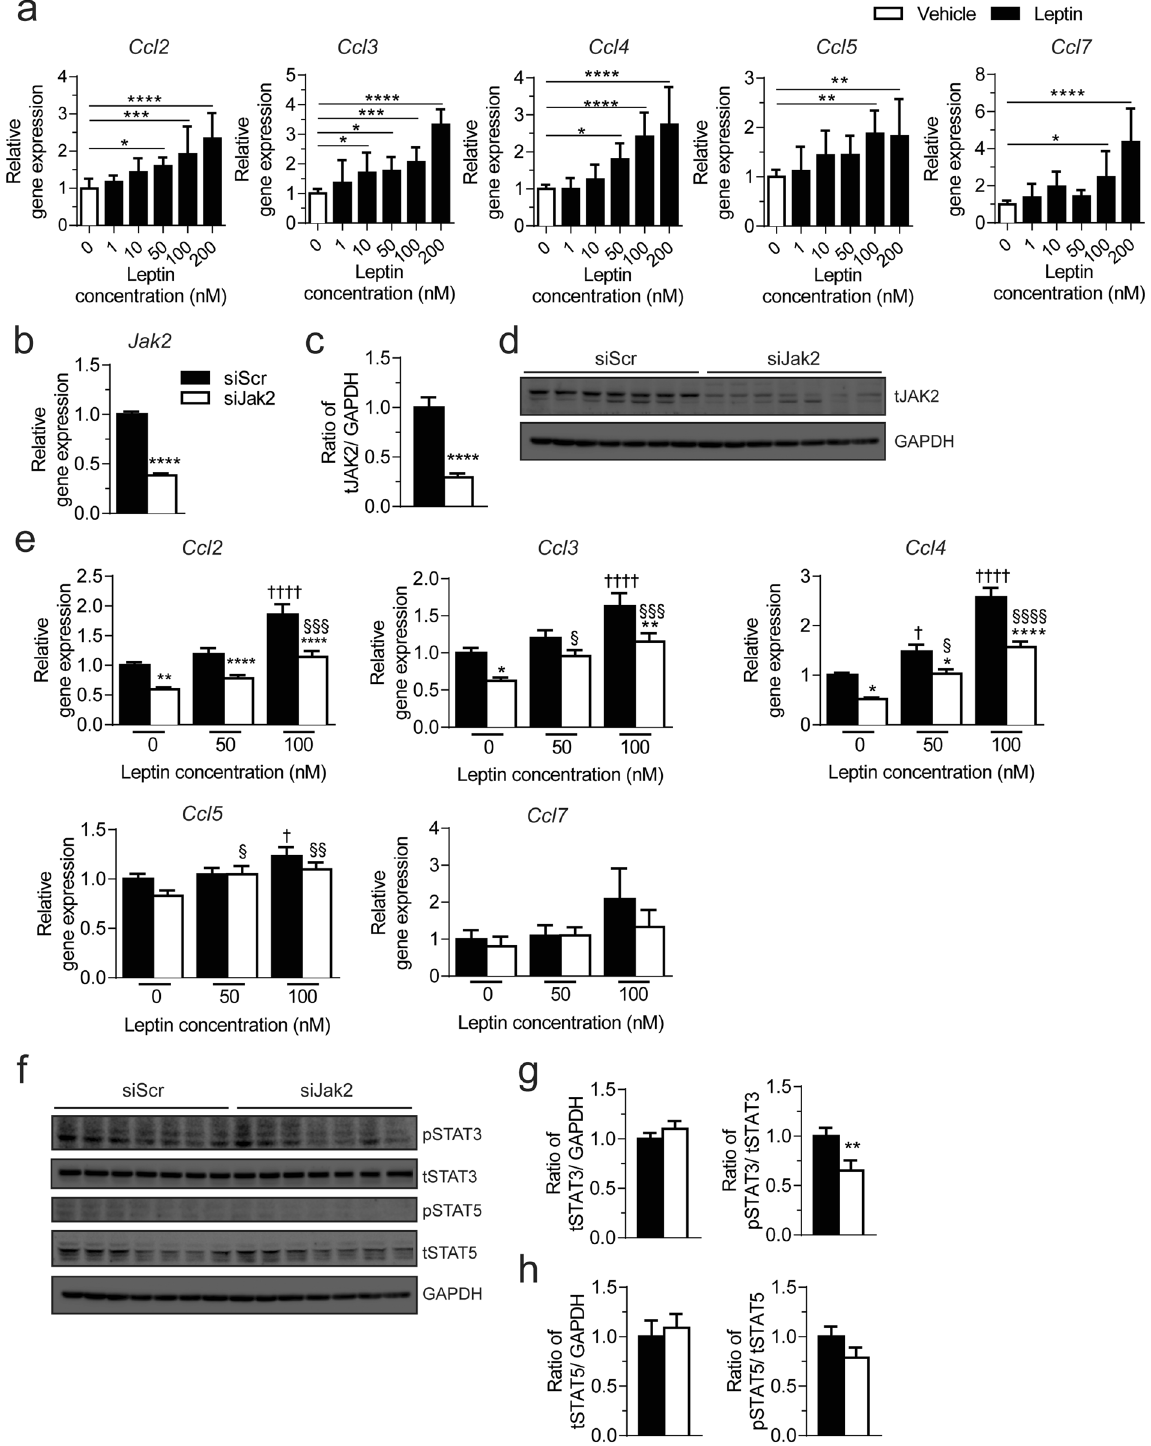
Figure 8. Chemokine expression in response to leptin in RAW 264.7 cells. ( a ) mRNA expression of chemokines as fold change over vehicle in macrophage cell line RAW 264.7 after stimulation with vehicle or varying concentrations of leptin. Three independent experiments performed in triplicates. ( b ) mRNA expression of Jak2 in RAW 264.7 cells transfected with scramble siRNA control (siScr) or Jak2 siRNA (siJak2) as fold change over siScr. ( c ) Quantification of total JAK2 levels relative to GAPDH, expressed as fold change over siScr, in RAW 264.7 cells transfected with siScr or siJak2 (n = 7). ( d ) Western blots of RAW 264.7 cells transfected with siScr or siJak2 for total JAK2 and GAPDH as a loading control. Full-length blots presented in Supplementary Fig. S9. ( e ) mRNA expression as fold change over vehicle-treated siScr of chemokines in response to vehicle or leptin (50 nM or 100 nM) in RAW 264.7 cells transfected with siScr or siJak2. Four independent experiments performed in triplicates; * siScr compared to siJak2, † vehicle treated siScr compared to leptin-treated